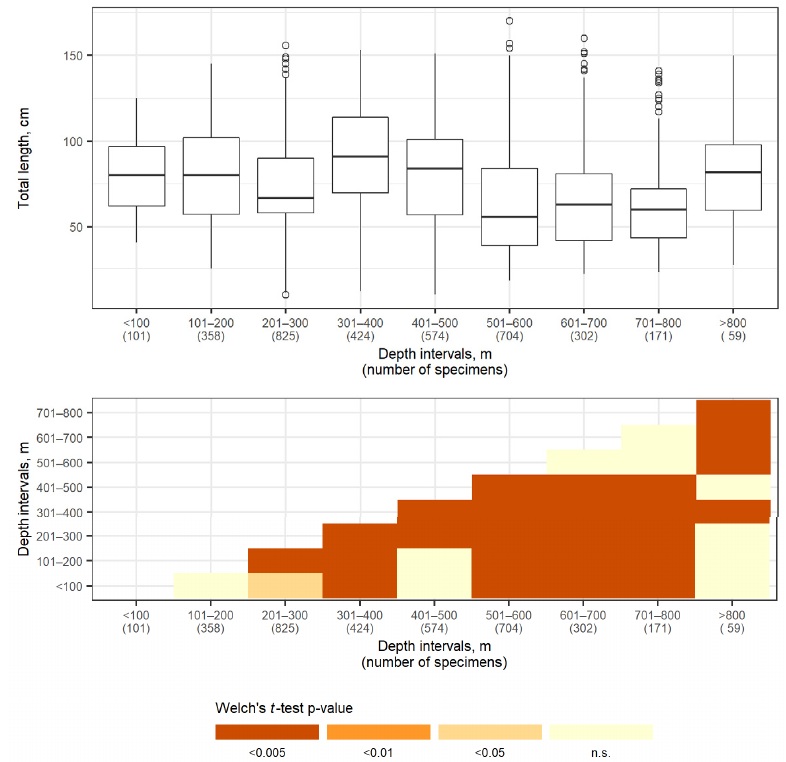
Figure 11. Distribution of the total length of Aleutian skate Bathyraja aleutica (cm) across selected depth intervals (m): box-plots of total length distribution (upper panel), circles denote outliers, and results of length distribution comparison at different depths by two-sided Welch’s t -test with Holm p -value adjustment (lower panel).